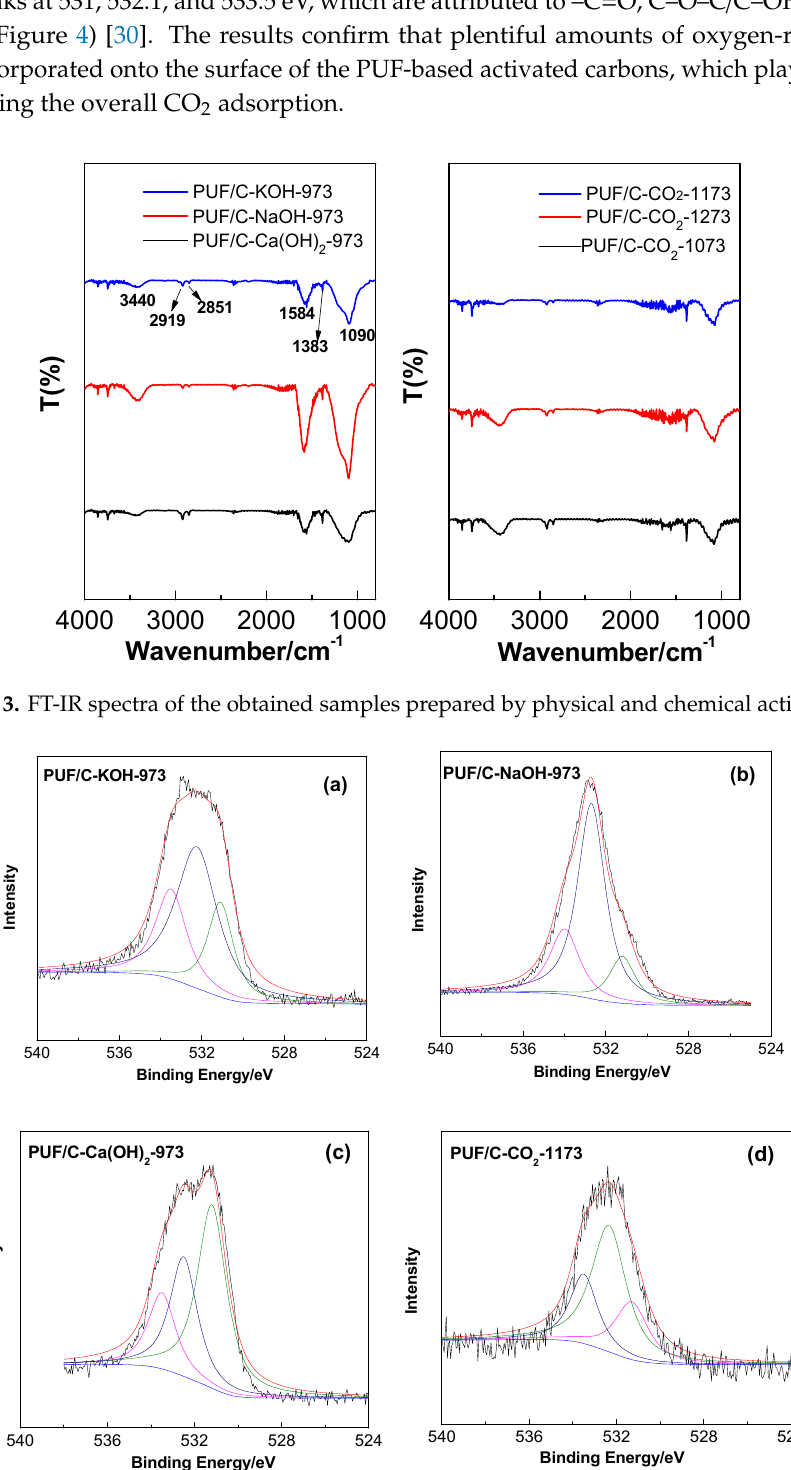
Figure 4. XPS spectra O 1s of PUF/C-KOH-973 ( a ), PUF/C-NaOH-973 ( b ), PUF/C-Ca(OH) 2 -973 ( c ), and PUF/C-CO 2 -1173 ( d